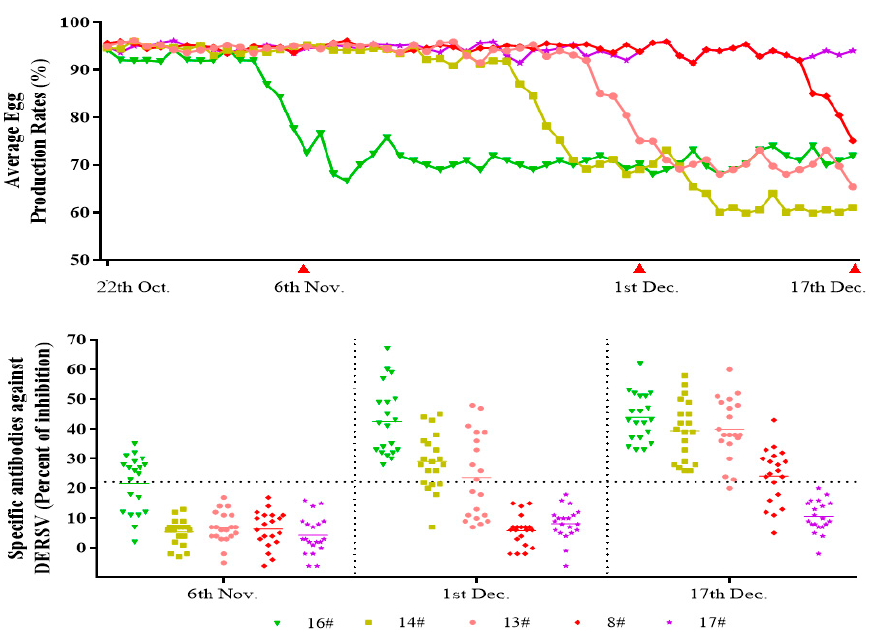
Figure 4. The correlation survey between the outbreaks of egg-reducing syndromes and the appearance of the specific antibodies against DERSV. In the early stage, the egg-reducing syndromes happened in one duck house. Meanwhile, the antibodies against DERSV were detectable in some serum samples, and seroconversion was found later in all the serum samples. In the other three duck houses, the egg-reducing syndromes happened one by one, and the antibodies against DERSV changed in a similar dynamic pattern as in the first duck house. The DERSV antibodies were not detected in the house without the egg-reducing syndrome.